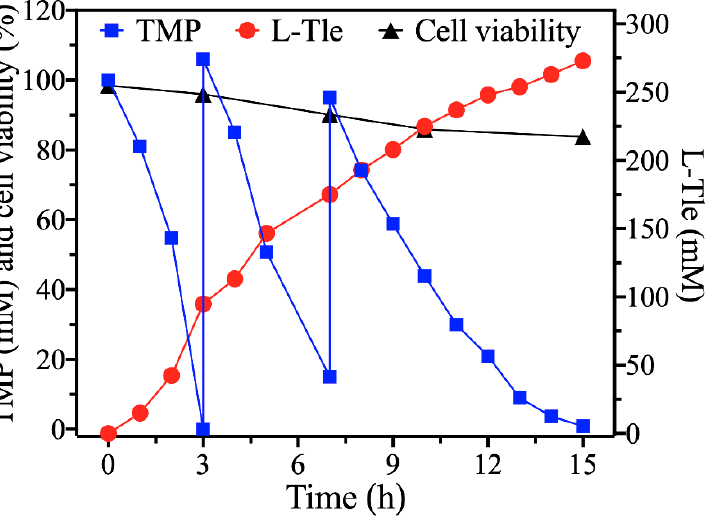
Figure 8. Fed-batch synthesis of L-Tle from TMP by recombinant E. coli -based whole-cell biocatalysis. The bioconversion was conducted at 30 °C and 200 rpm in flasks (500 mL) containing 100-mL reaction mixtures. Reaction mixtures: three additions of TMP solution (0, 3, and 7 h, final concentration 286 mM), glucose (400 mM), NH 4 Cl (300 mM), and 20 g L − 1 E. coli (pET28a- Pbleudh - Bmgd h) wet cells. The pH of the reaction system was set at 8.5 using 4 M NaOH and always maintained at 8.5 via automatic addition of 50% NH 3 ·H 2 O during the reaction process.